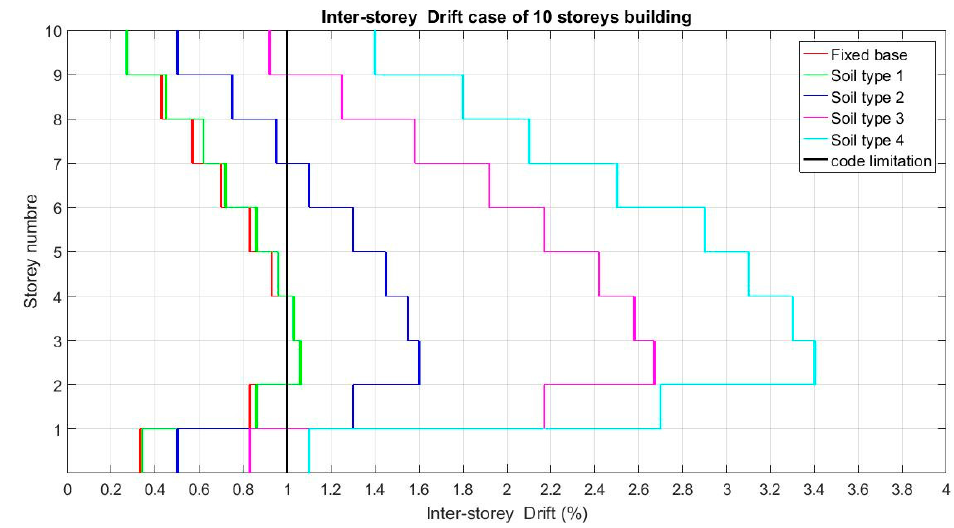
Figure 9. Inter-story drift case of an 8-story building .